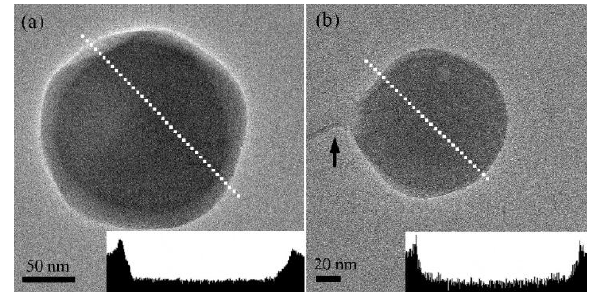
Figure 7. TEM images of (a) an amorphous carbonaceous sphere collected at 450 m, (b) another one with a tail (arrow). Insets are the profiles for the dashed line across the spheres.